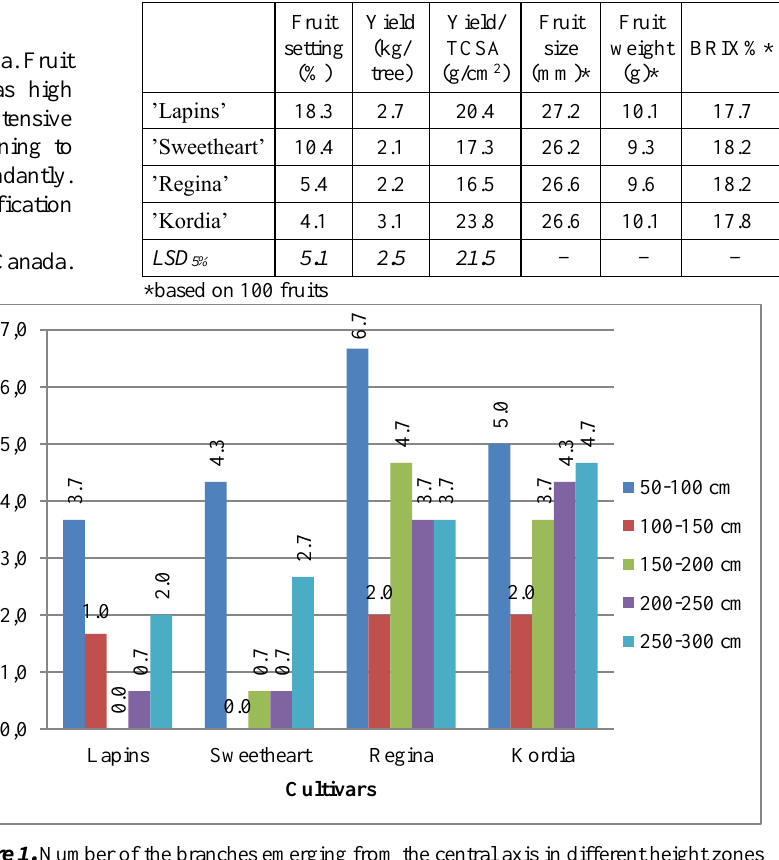
Table 3 . Generative achievement of the examined sweet cherry